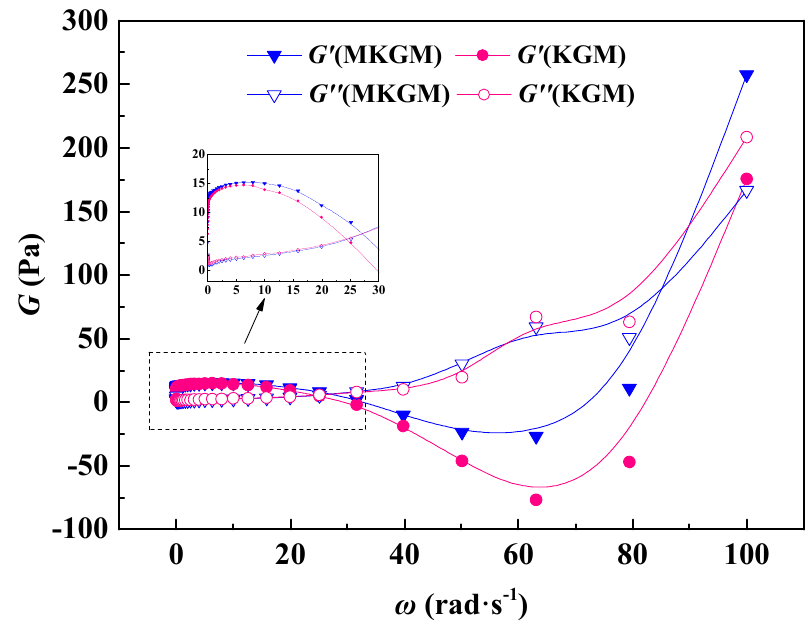
Figure 8. The variation of elastic modulus and the viscous modulus with frequency.